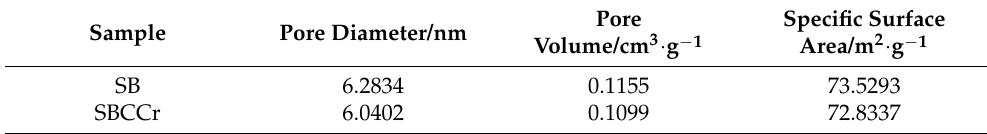
Table 1. The surface area, pore volume, and pore diameter of SB and